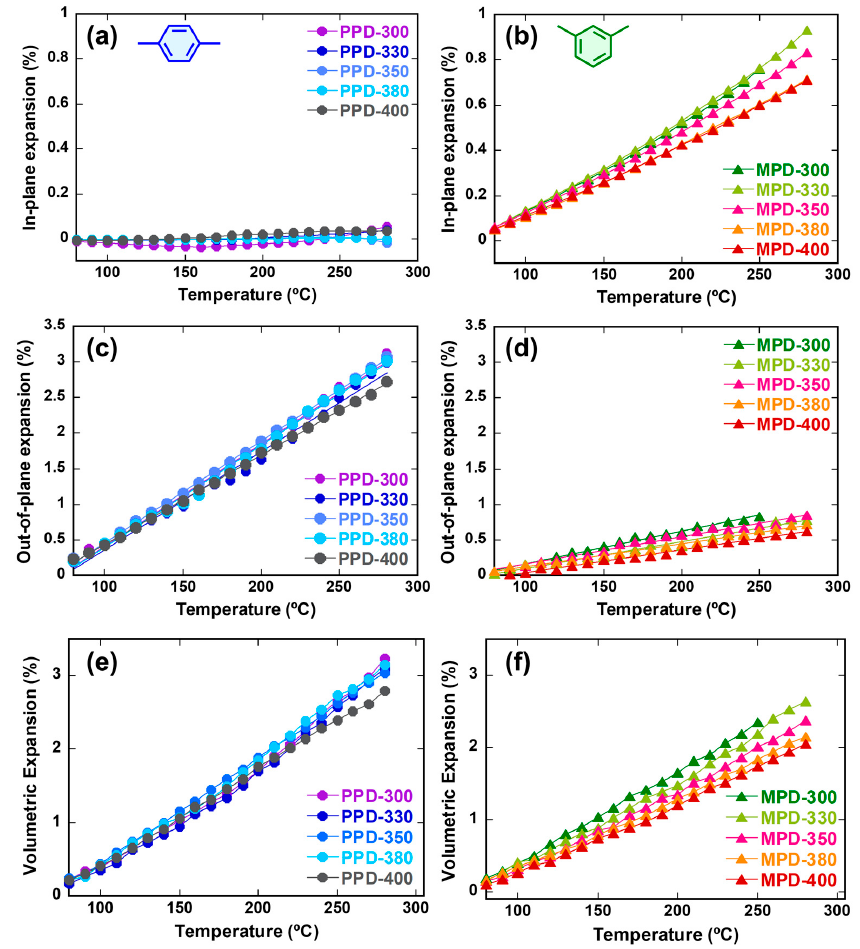
Figure 7. ( a , b ) In-plane, ( c , d ) out-of-plane, and ( e , f ) volumetric thermal expansion behaviors of PI films derived from PPD (left-hand-side) and MPD (right-hand-side). Table 4. Coefficient of thermal expansion (CTE) in the in-plane direction of the PI film (CTE // ) and in the out-of-plane direction (CTE ⊥ ) , as well as the coefficient of volumetric thermal expansion (CVE), anisotropy in CTE ( η ), and β -transition temperatures determined by the dynamic mechanical analysis